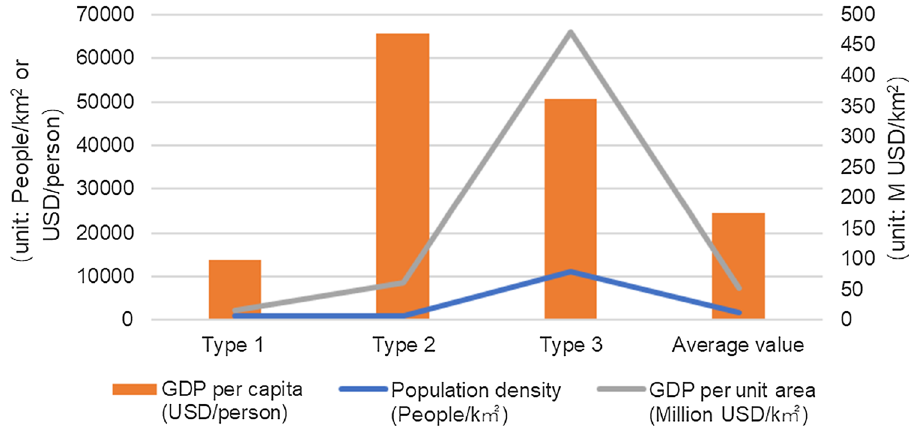
Fig. 5 Data of Type 1–3 cities